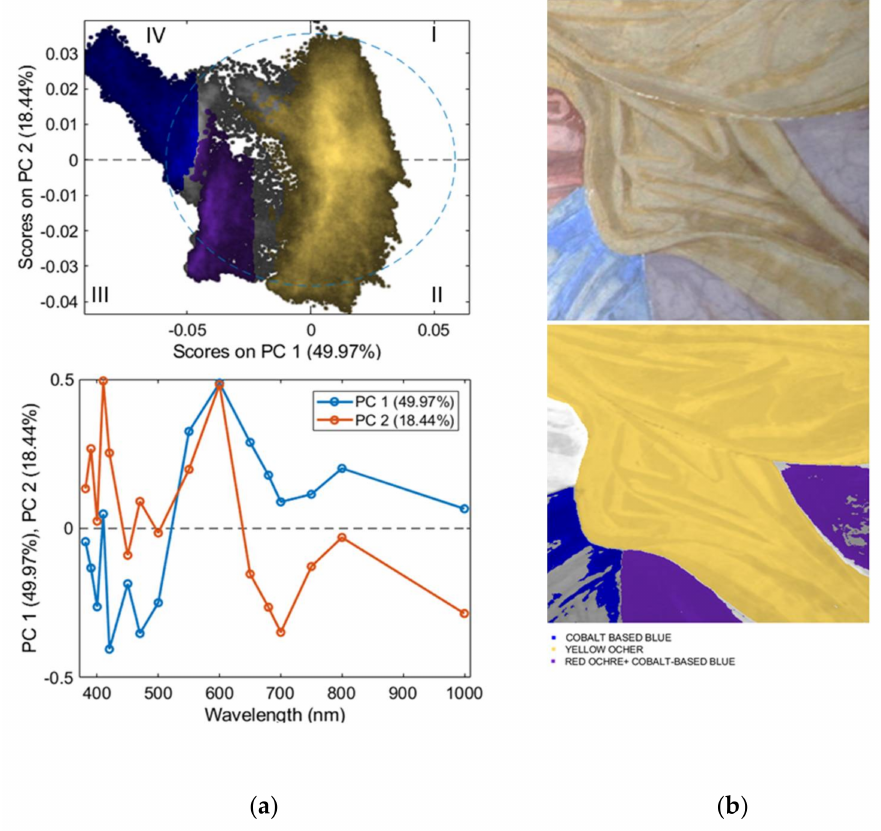
Figure 9. PCA score and loading plot of PC1 and PC2 ( a ) and relative false color image of AREA 1 ( b